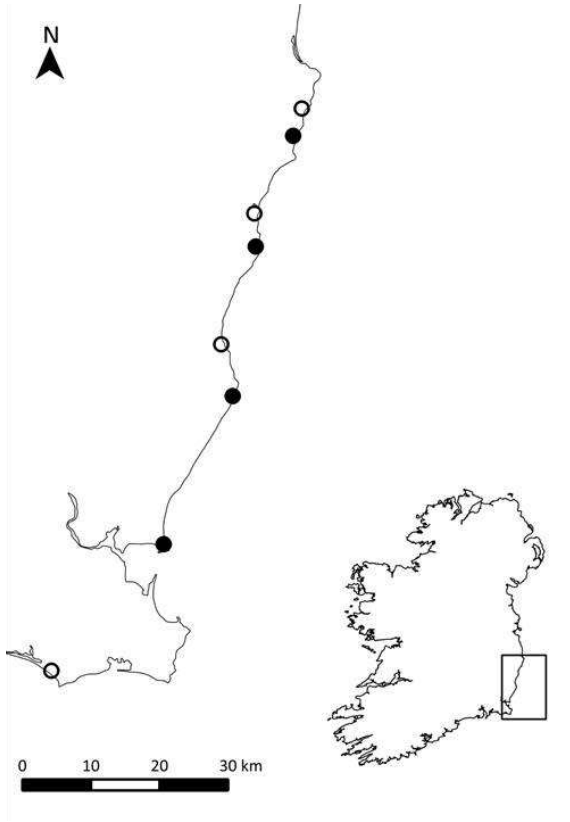
F IGURE 1. Distribution of study sites in SE Ireland. Closed circles indicate sites where S. repens was present; open circles indicate sites where it was not. Site names (North-South) = Magherabeg, Brittas, Arklow, Kilpatrick, Courtown, Cahore, Raven Point, and Ballyteige